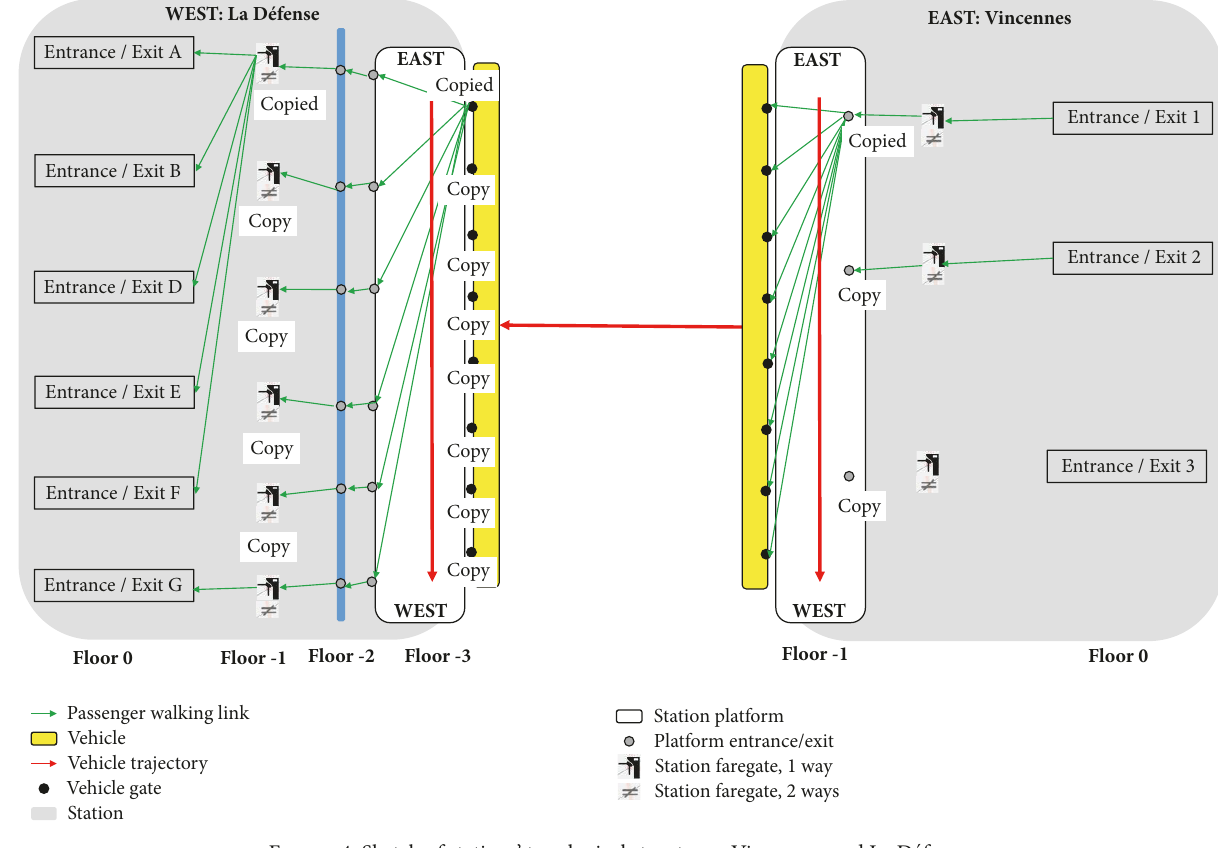
Figure 4: Sketch of stations’ topological structures: Vincennes and La D´efense.